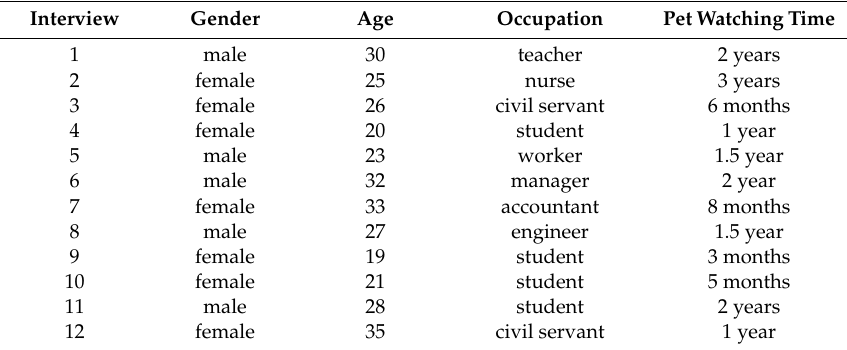
Table 1. Interview information on the